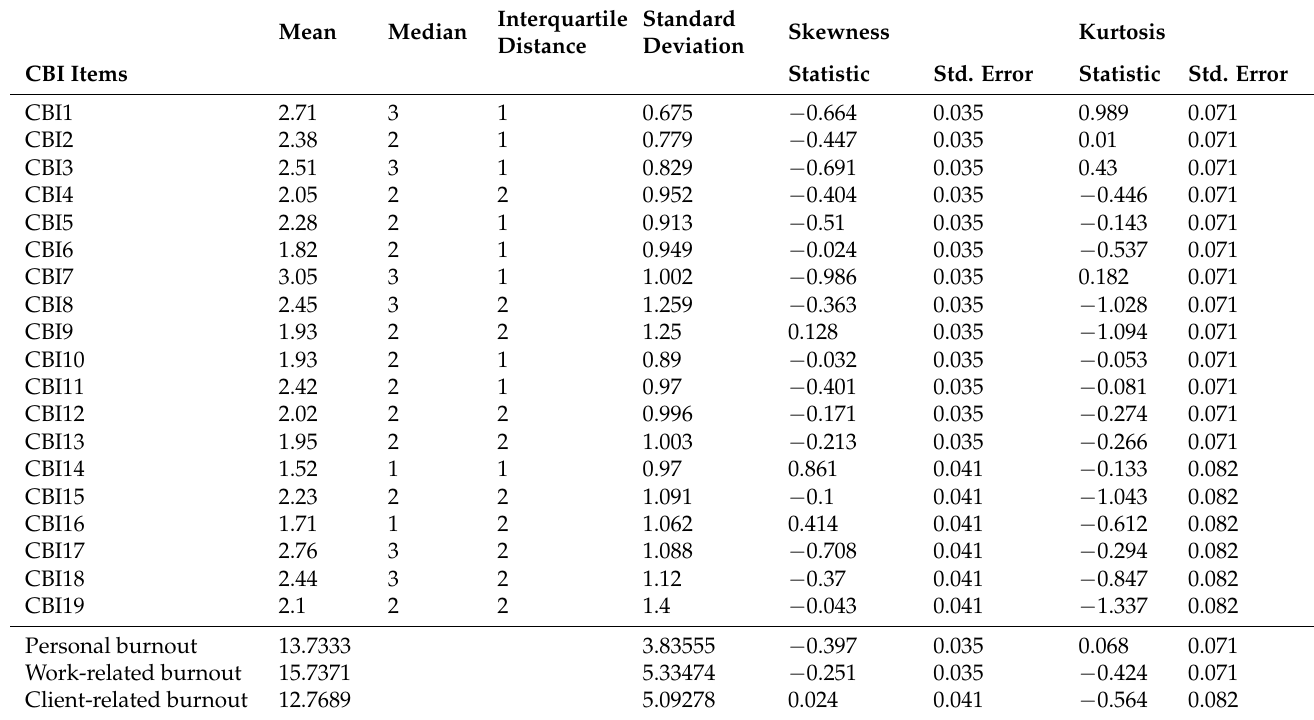
Table 1. Descriptive analysis of the CBI items—sample one.